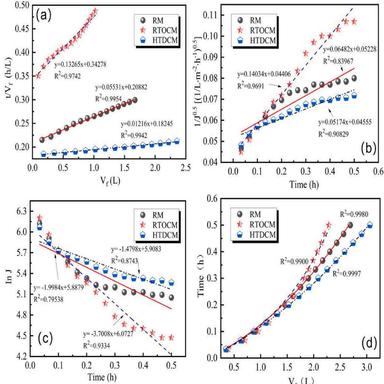
Experimental data of RM, RTOCM and HTDCM in the first cycle of filtration predicted by the (a) CF, (b) PN, (c), PB, and (d) MF models.